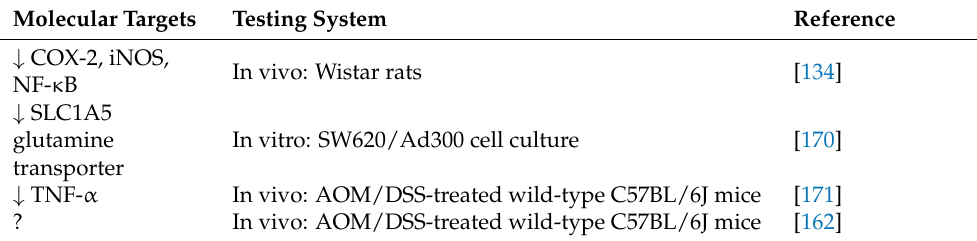
Table 9. Reported targets of quercetin active in the reduction in inflammation of CRC models alongside their in vivo/in vitro testing system. “ ↓ ” arrows are indicating the downregulation, while “?” denotes the lack of specific targets in the respective